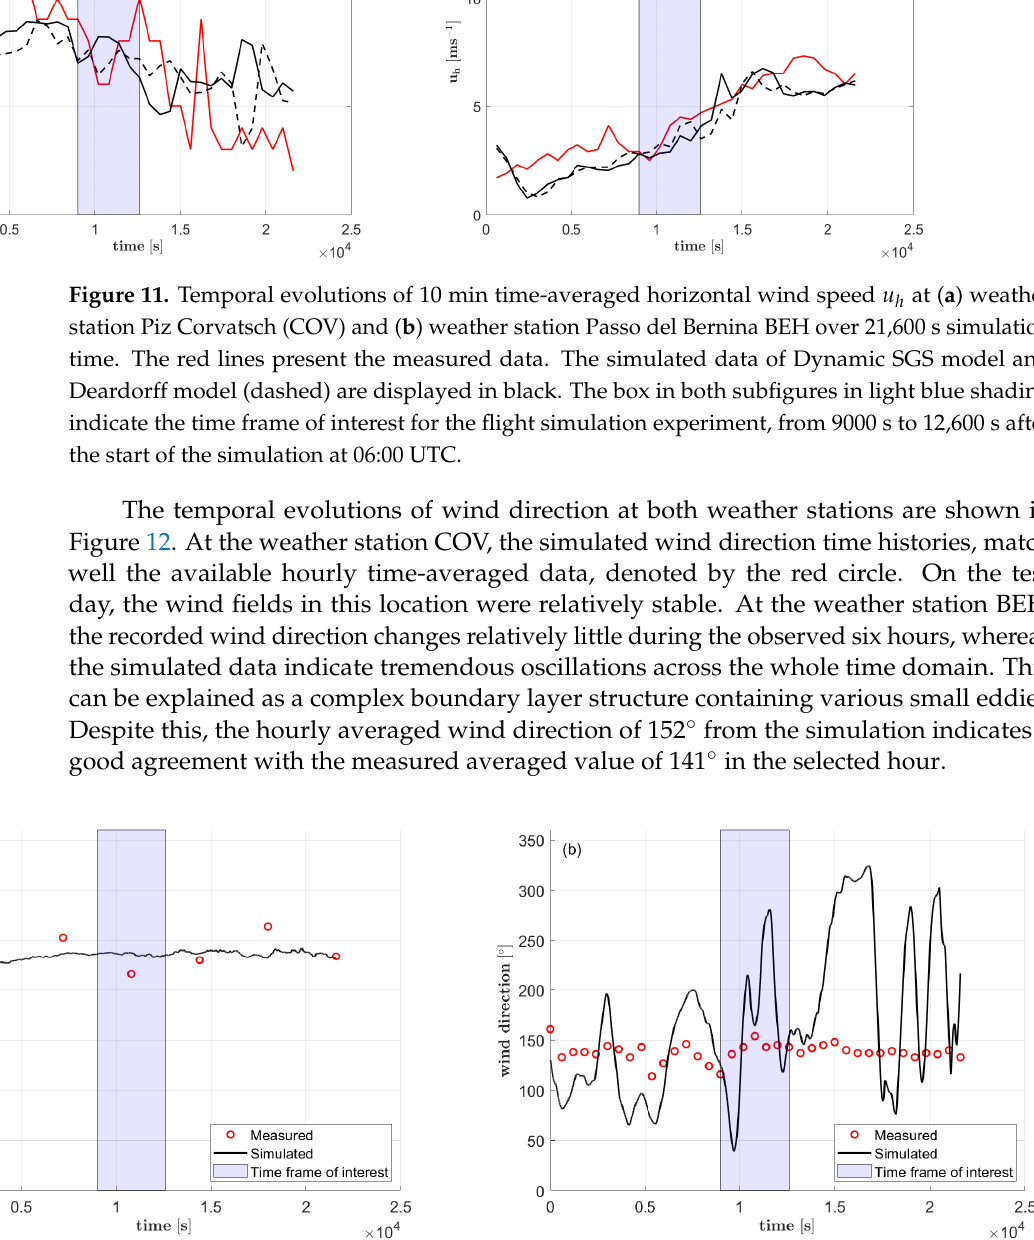
Figure 12. Temporal evolutions of wind direction at ( a ) weather station Piz Corvatsch (COV) and ( b ) weather station Passo del Bernina (BEH) over 21,600 s simulation time. The red scattered points solid lines present the hourly time-averaged measured data at COV and the 10-min averaged data at BEH. The solid lines represented 10 min time-averaged wind direction derived from the simulation. The box in both subfigures in light blue shading indicate the time frame of interest for the flight simulation experiment, from 9000 s to 12,600 s after the start of the simulation at 06:00